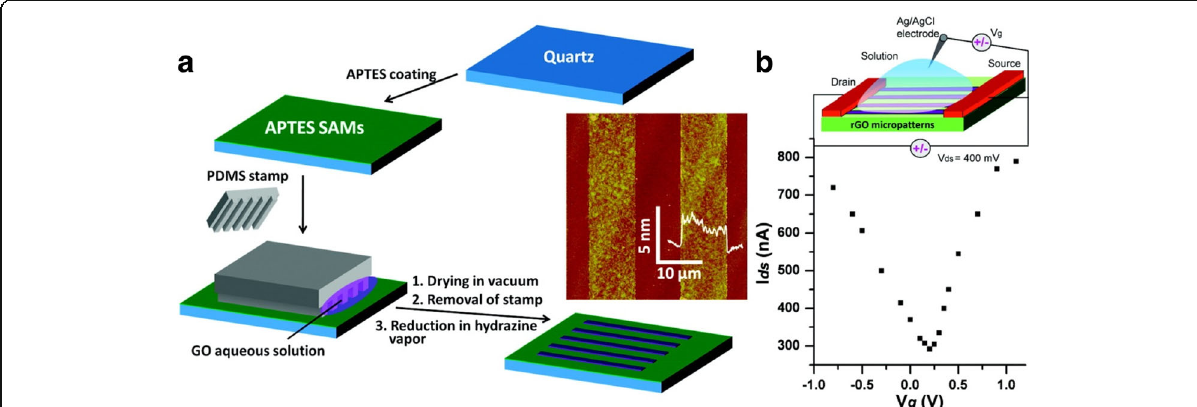
Fig. 4 a Schematic illustration for fabrication of patterned rGO thin films on APTES-coated quartz. b Ambipolar characteristics of rGO-FET measured in buffer solution. (Reprinted with permission from Reference Sudibya et al. 2011). © 2011 American Chemical Society